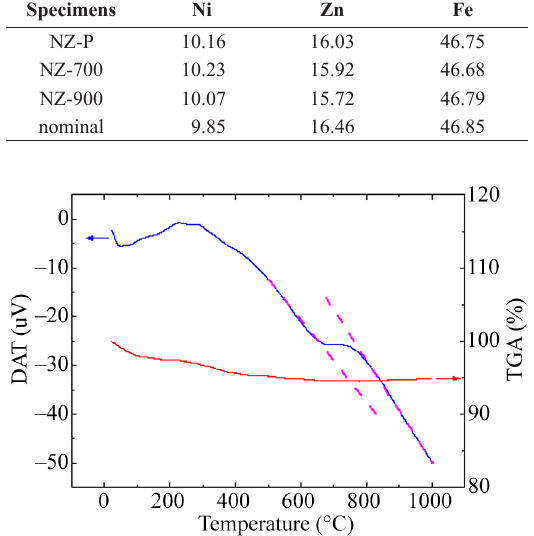
Figure 3. TGA-DTA curves of specimen NZ-P. The dash lines are guide for eyes.